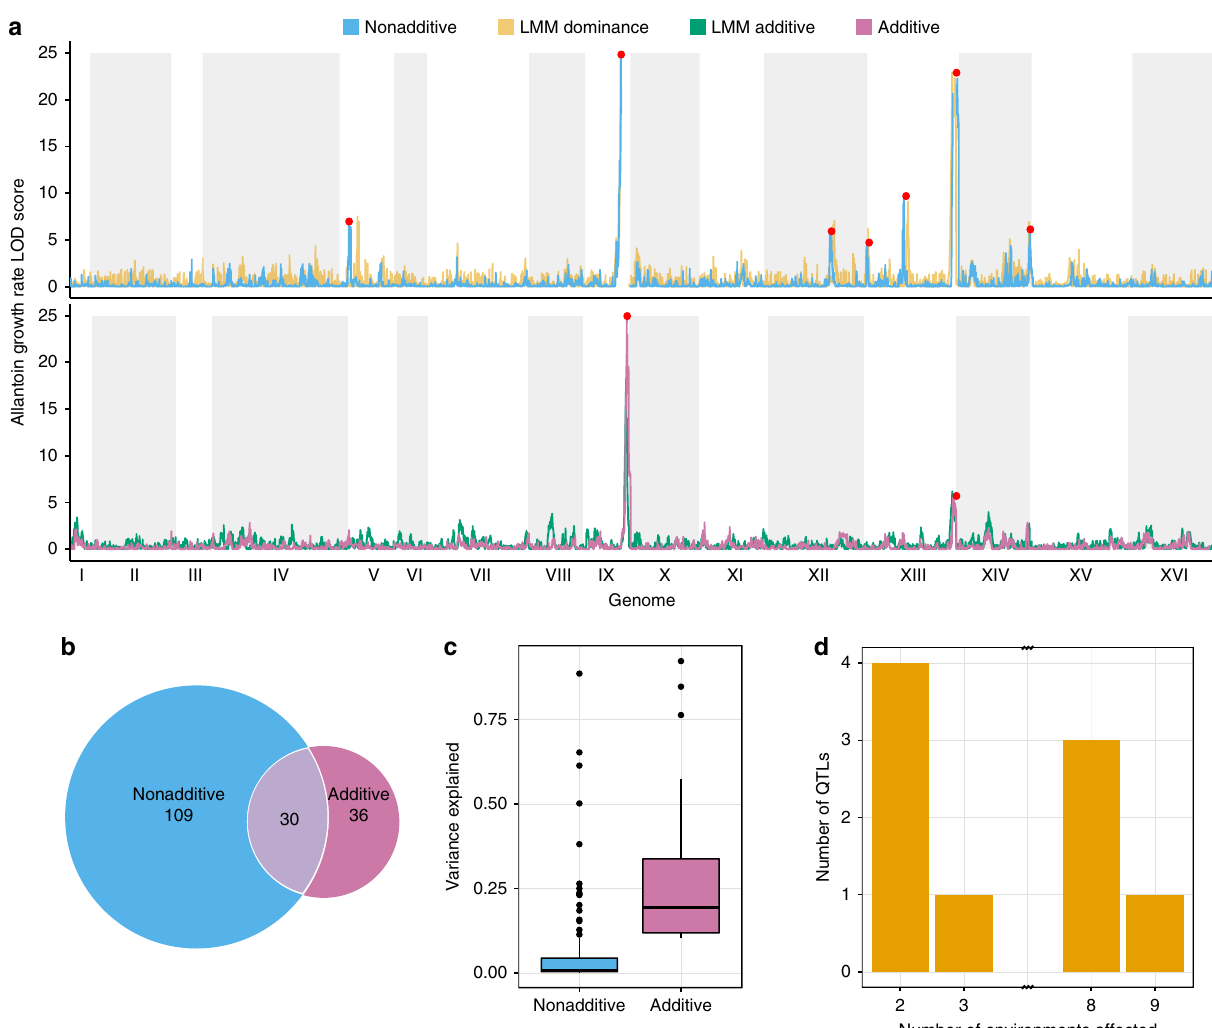
Figure 3 | Cost-efficient QTL mapping in yeast POLs. QTLs were mapped across 6,642 genomes and 18 traits based on additive and nonadditive contributions. QTLs were validated as additive or dominant genetic contributions using Linear Mixed Models (LMM). ( a ) QTL signal strength (LOD score, y -axis) as a function of genomic position ( x -axis), for growth rate on allantoin as sole nitrogen source, using additive (LMM and non-LMM; lower panel) and nonadditive (non-LMM and LMM only capturing dominance; upper panel) models. Red dots indicate significant (FDR, q ¼ 10%) QTL calls. White/grey fields indicate chromosome spans. ( b ) Venn diagram of significant QTLs capturing additive and nonadditive genetic contributions. All 18 phenotypes (growth rate and mean growth over nine environments) were considered, with pleiotropic QTLs counted multiple times. ( c ) Tukey boxplot showing the fraction of variance explained by additive (purple) and nonadditive (blue) significant QTLs (non-LMM models). ( d ) Histogram of pleiotropic QTLs. A QTL was counted as shared across environments if peaks were within 10kb of each other. No QTLs were significant in 4, 5, 6 or 7